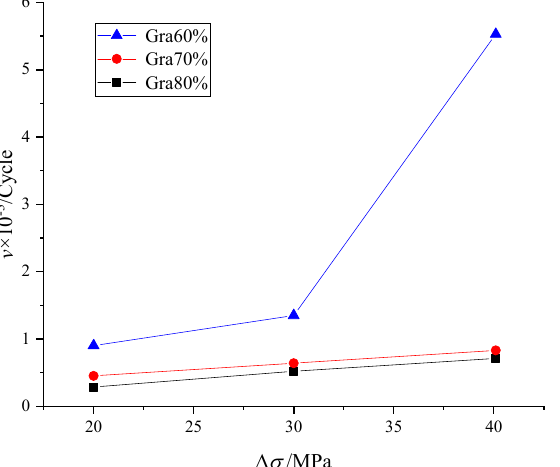
Figure 18. Rates of change of the damage variable of the rock in the steady increase stage .